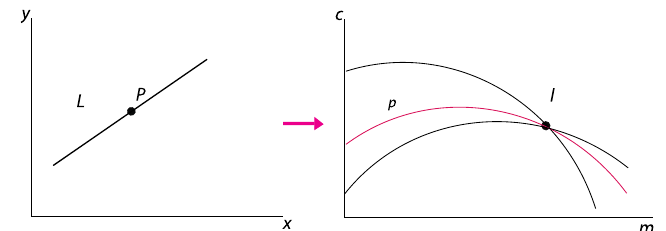
Figure 4. Lines through a point in the image space and ( m , c )